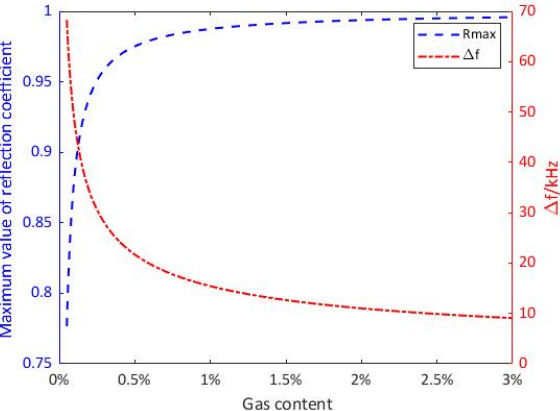
Figure 4. Variation of the maximum value of reflection coefficient and valley frequency intervals with gas content.